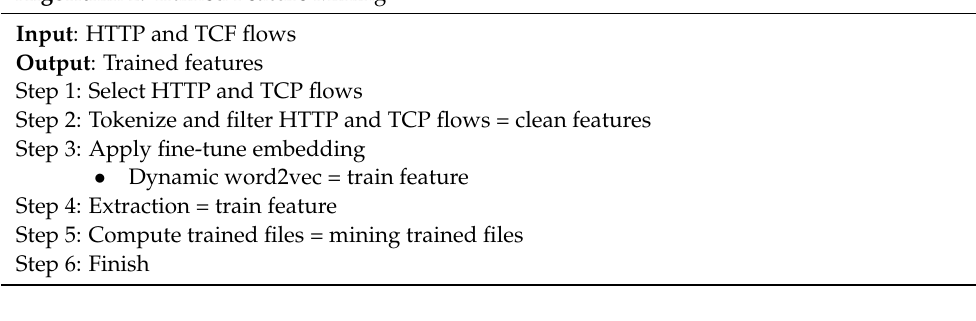
Algorithm 2: Trained Feature Mining